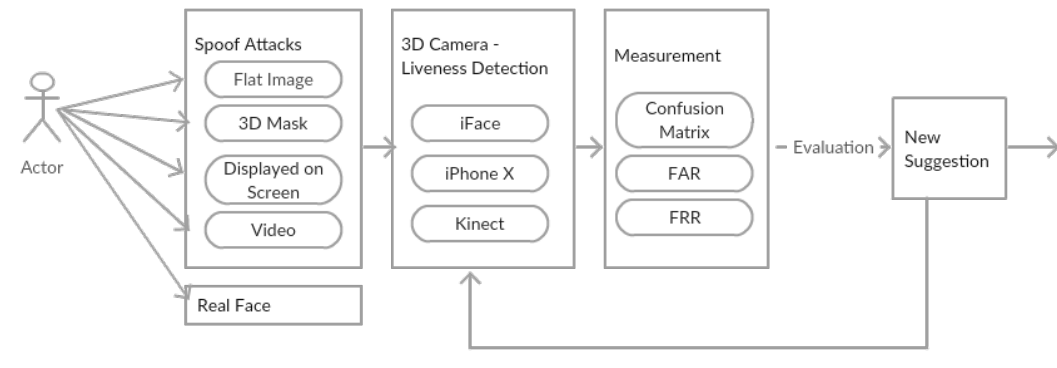
Figure 2. Flowchart of the